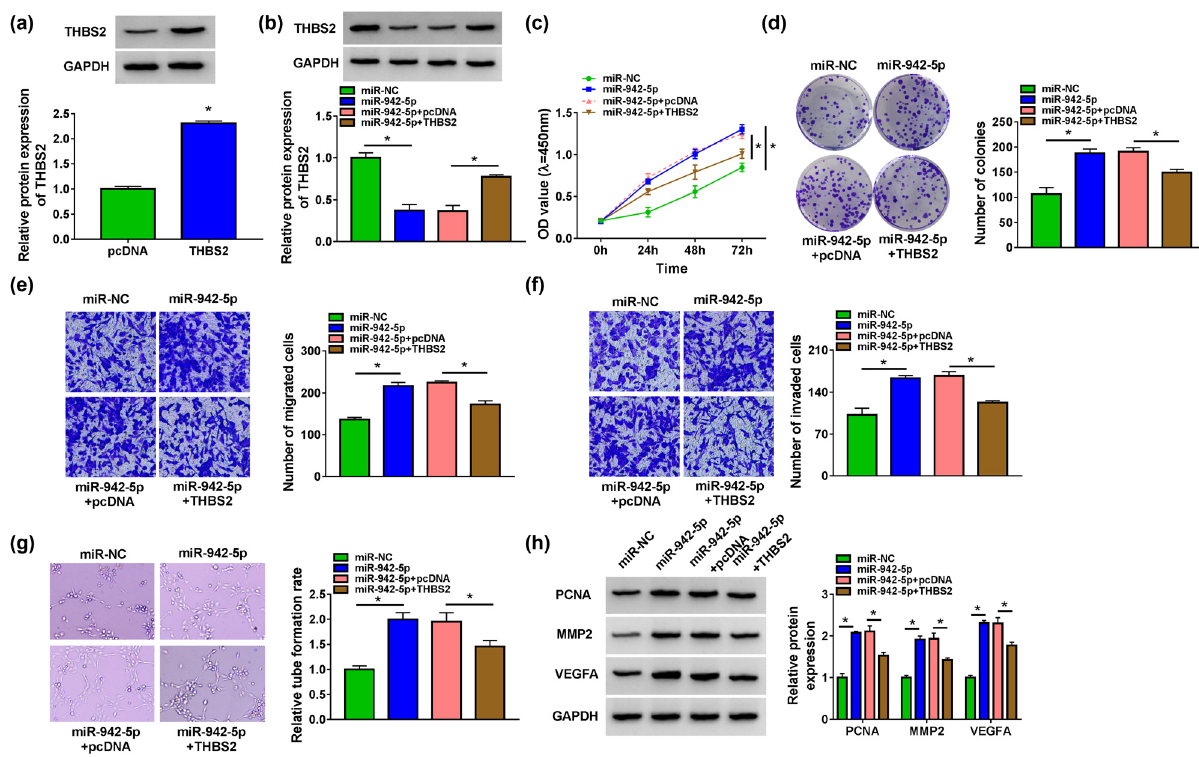
Figure 6: E ff ects of miR - 942 - 5p and THBS2 on the biological functions of HTR8/SVneo cells. ( a ) The protein expression of THBS2 was detected by WB analysis to assess the transfection e ffi ciency of THBS2 overexpression vector. ( b – h ) HTR - 8/SVneo cells were transfected with miR - NC, miR - 942 - 5p, miR - 942 - 5p + pcDNA, or miR - 942 - 5p + THBS2. ( b ) The protein expression of THBS2 was examined by WB analysis. CCK8 assay ( c ) , colony formation assay ( d ) , Transwell assay ( e and f ) , and tube formation assay ( g ) were measured by cell proliferation, migration, invasion, and angiogenesis, respectively. ( h ) The protein levels of PCNA, MMP2, and VEGFA were determined by WB analysis. * P <